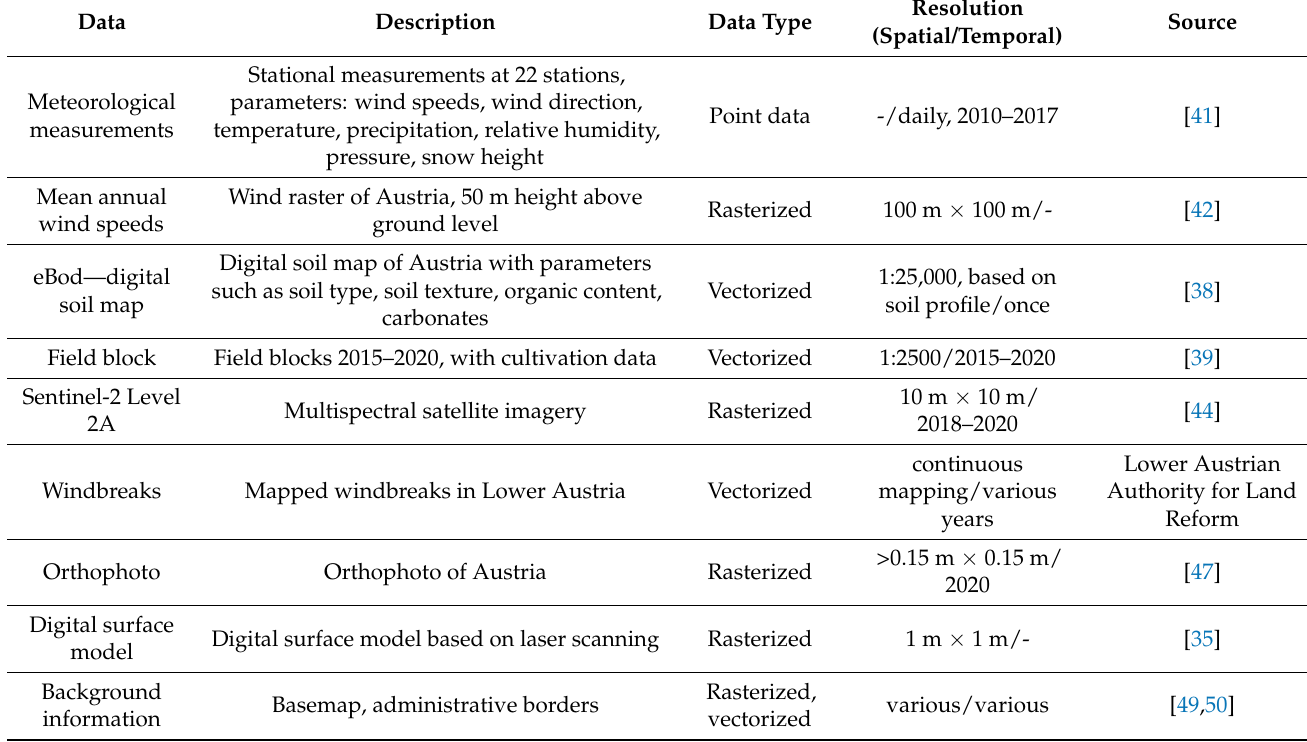
Table 1. Data description, resolution, and sources of datasets used for the mapping and modeling approach of wind erosion.